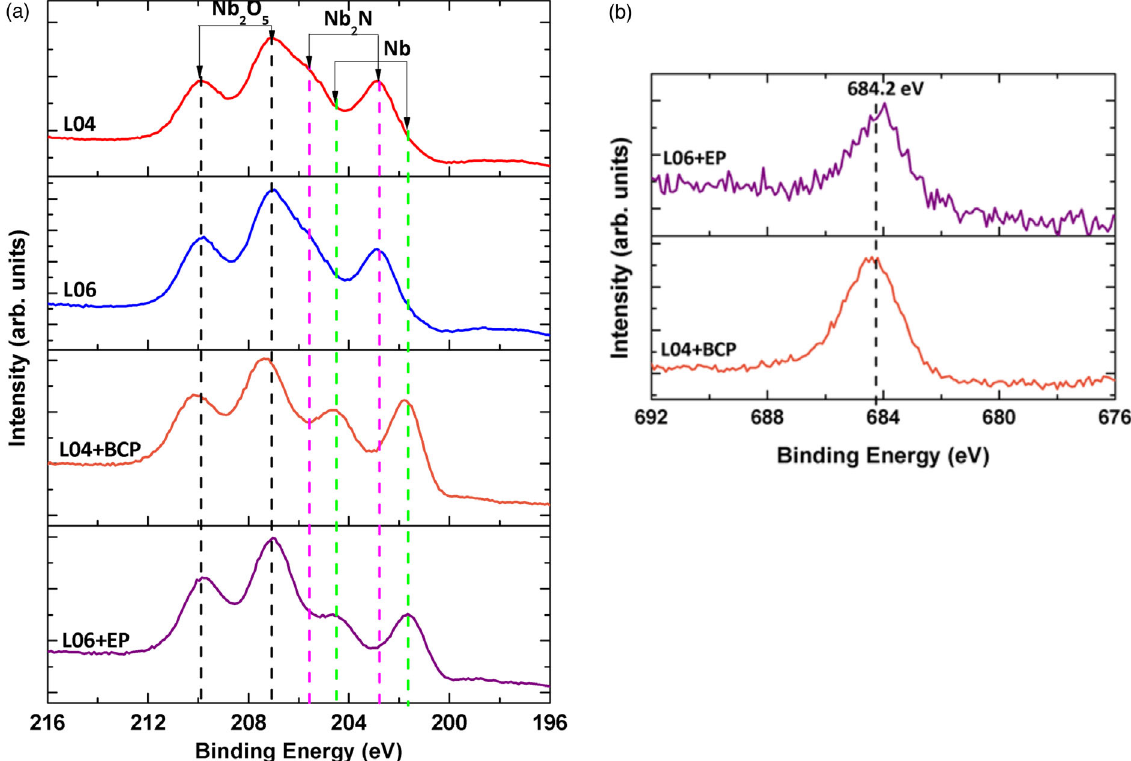
FIG. 6. (a) Nb 3d XPS spectra (takeoff angle of 75°) of N-doped Nb samples before and after the ∼ 6 μ m surface removal with BCP and EP. (b) Fluoride 1s XPS spectra (takeoff angle of 75°) at 684.2 eV of N-doped Nb samples after the ∼ 6 μ m surface removal with BCP and